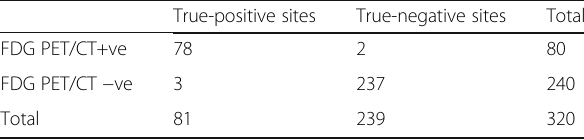
Table 1 Correlation between FDG-PET/CT and the reference